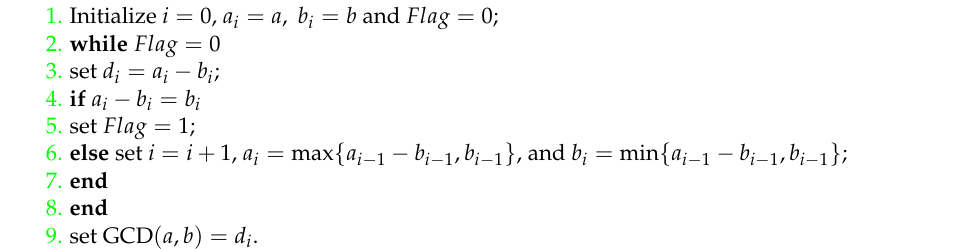
Table 1. Pseudocode of the Euclidean algorithm (repeated differences).